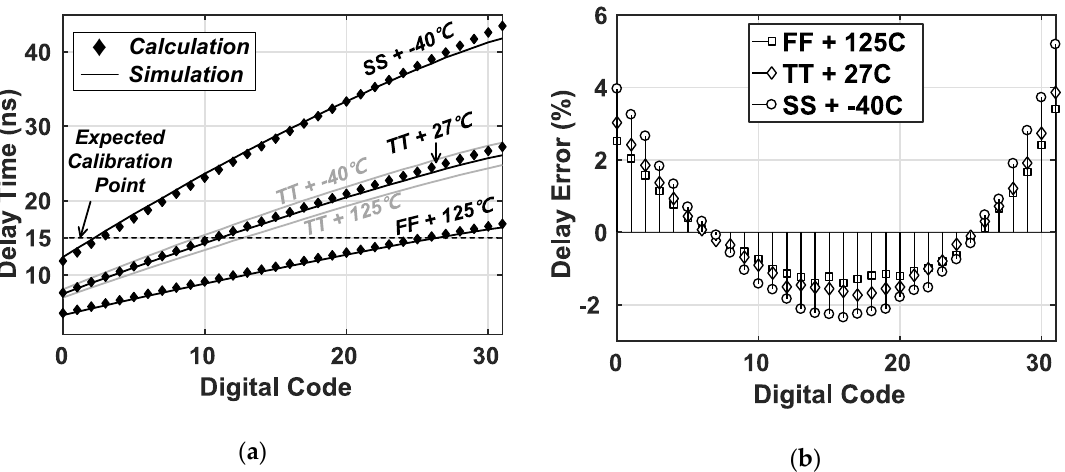
Figure 9. ( a ) Calculation and SPICE simulation results of delay versus the delay codes; ( b ) linearity of proposed delay cell from SPICE simulation.